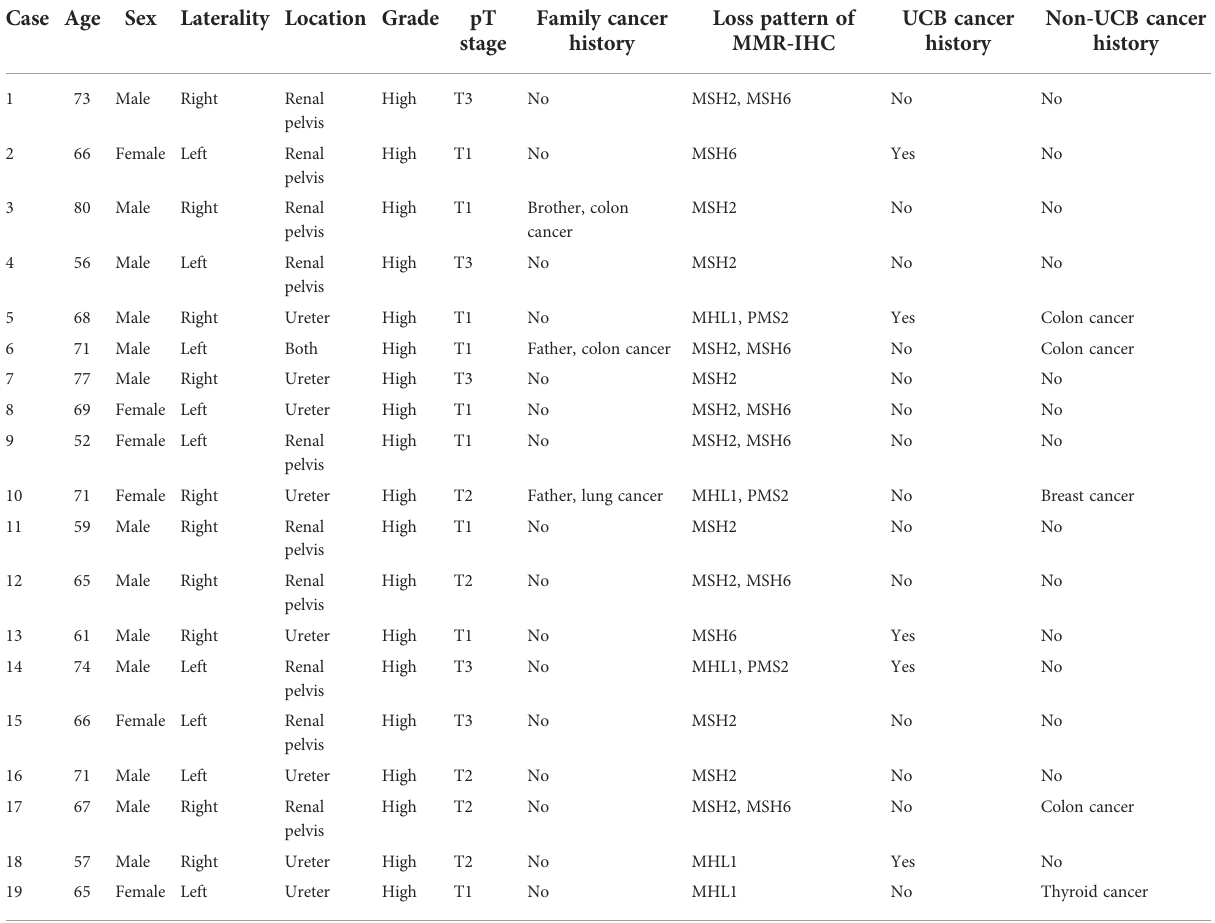
TABLE 2 Data of patients with loss of MMR protein.